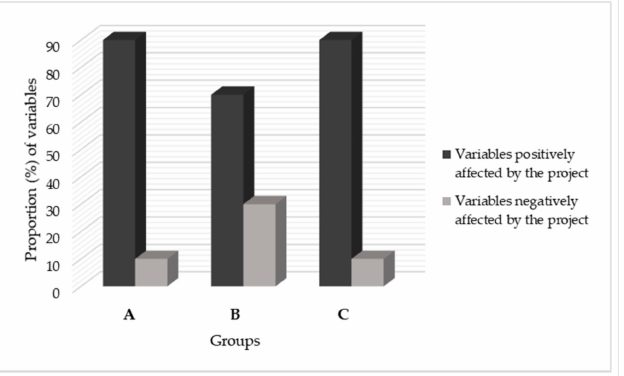
Figure 4. Group perceptions of the PES project including: A: village chiefs and community represen- tatives, B: Resources management committees in the local association, C: teachers and community health